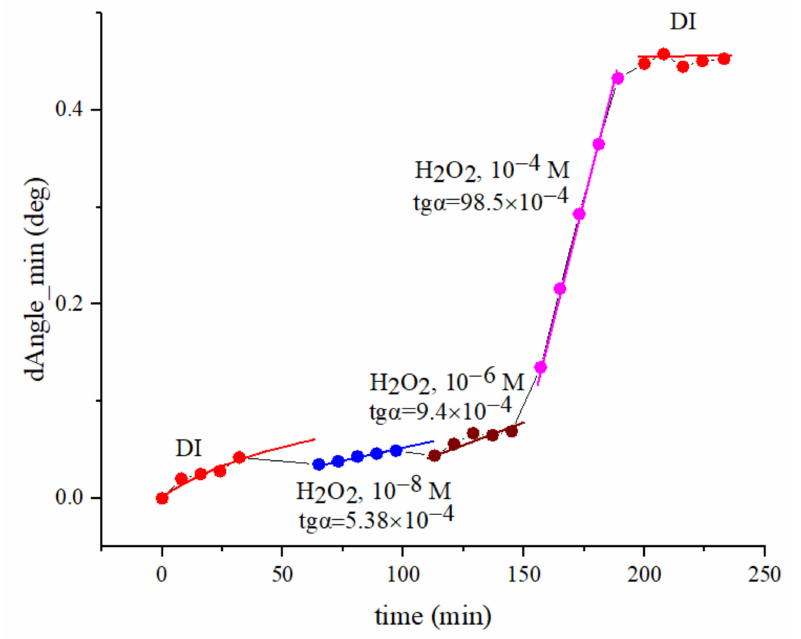
Figure 3. Shift in the resonance minima during the interaction of hydrogen peroxide solutions with concentrations of 10 − 8 M, 10 − 6 M, and 10 − 4 M with the Au/AgI surface. 3.1.2. Measuring the SEW Excitation Angle on a Two-Layer Au/Ag substrate As indicated, along with measurements on the Au/Ag structure, measurements were carried out on the sensitive Au/Ag layer. The measurements were performed for solutions of H 2 O 2 with concentrations of 10 − 10 M and 10 − 8 M. Figure 4 shows the diagrams of dependences obtained for shifts in the resonance minima during the SEW excitation.